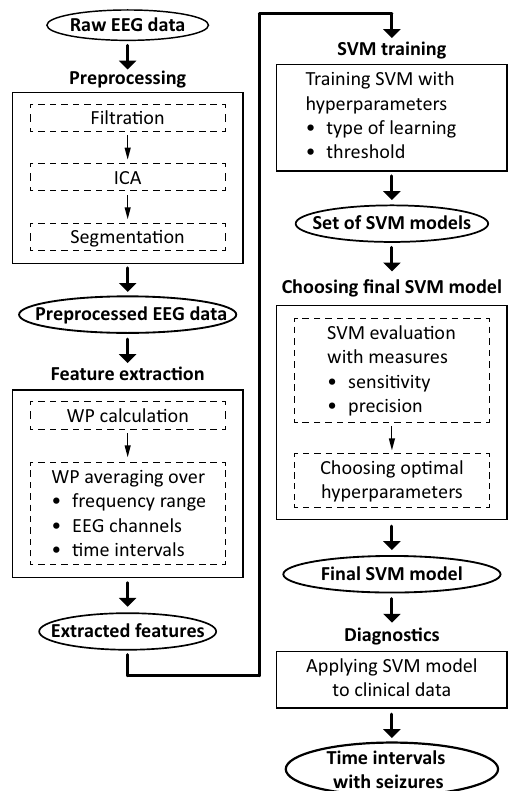
Figure 2. The framework of the ML algorithm. Rectangle frames depict steps of data analysis, oval frames correspond to the input/output data for each